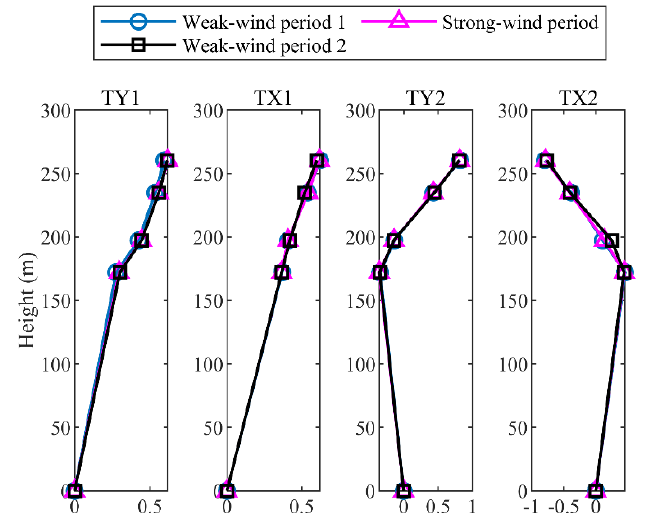
Figure 13. Variation in mode shape.